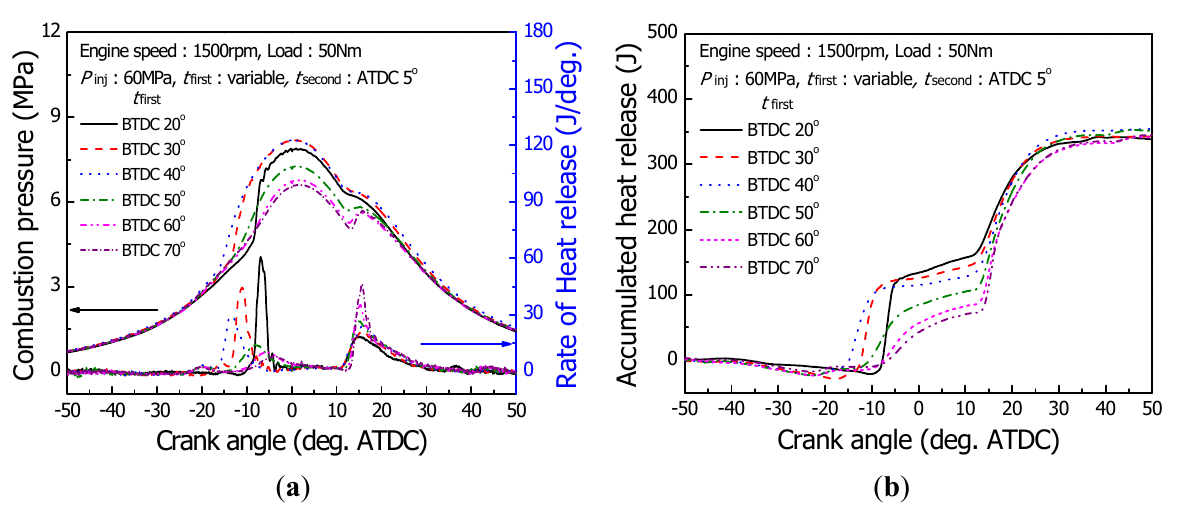
Figure 3. Combustion characteristics according to variable first injection timing of two stage injection: ( a ) Combustion pressure and rate of heat release; ( b ) Accumulated heat